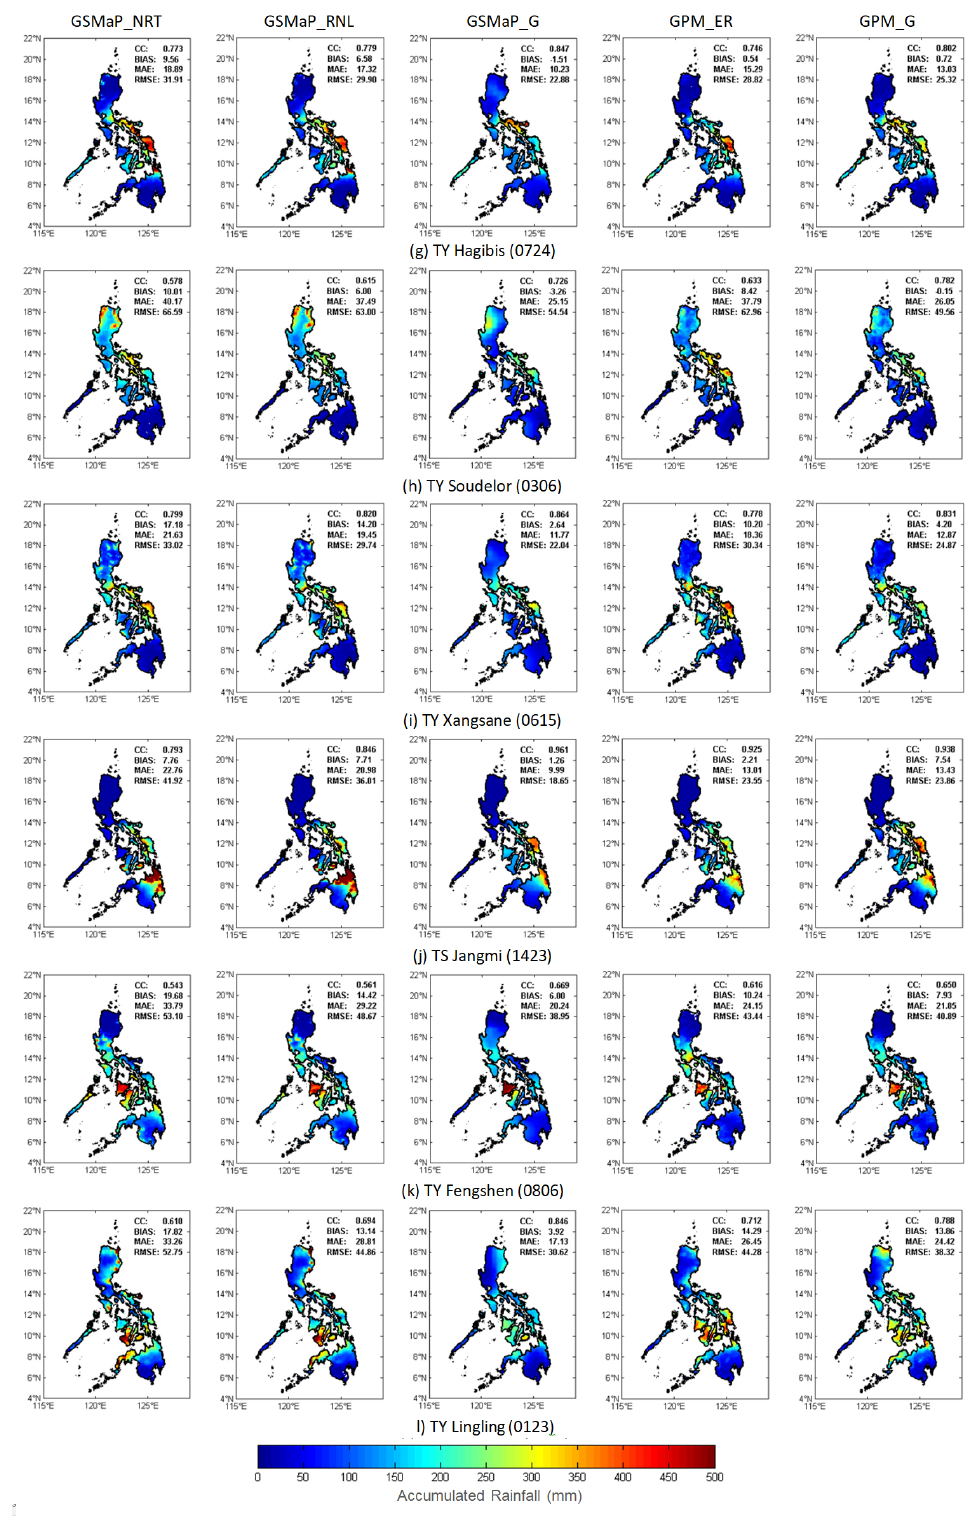
Figure 2. TC Rainfall estimation maps of ( a ) TY Kai-Tak (0004), ( b ) TY Mangkhut (1822), ( c ) TY Parma (0917), ( d ) TY Melor (1527), ( e ) TY Ketsana (0916), ( f ) STS Nock-Ten (1108), ( g ) TY Hagibis (0724), ( h ) TY Soudelor (0306), ( i ) TY Xangsane (0615), ( j ) TS Jangmi (1423), ( k ) TY Fengshen (0806), and ( l ) TY Lingling (0123). The numbers are the JMA best track TC ID, the first 2 digits indicate the year, and the last 2 digits are the chronological order of occurrence of the TC within a